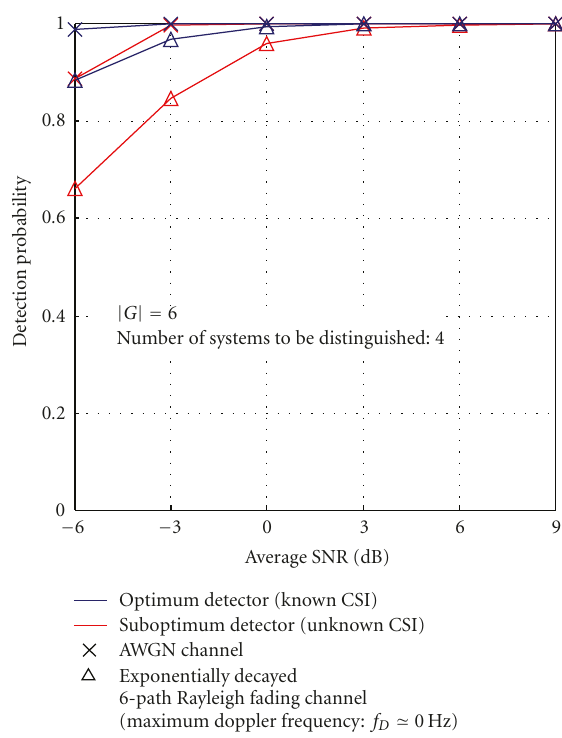
Figure 9: Performance for Method A: optimum and suboptimum